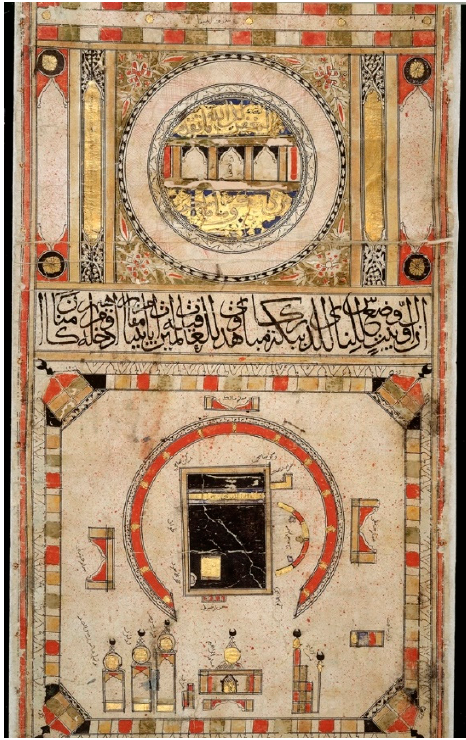
Figure 7. A section of a pilgrimage scroll showing examples of schematic depictions of holy places in the Ḥ ij ā z; the entirety or portions of such scrolls would have been mounted on mosque walls for public display, a function that may well have been in the makers’ minds given the scale of the depictions. This example was completed around the year 1433 and displays the increasingly sophisticated visual repertoire that developed within the genre. British Library, Add. MS 27566.